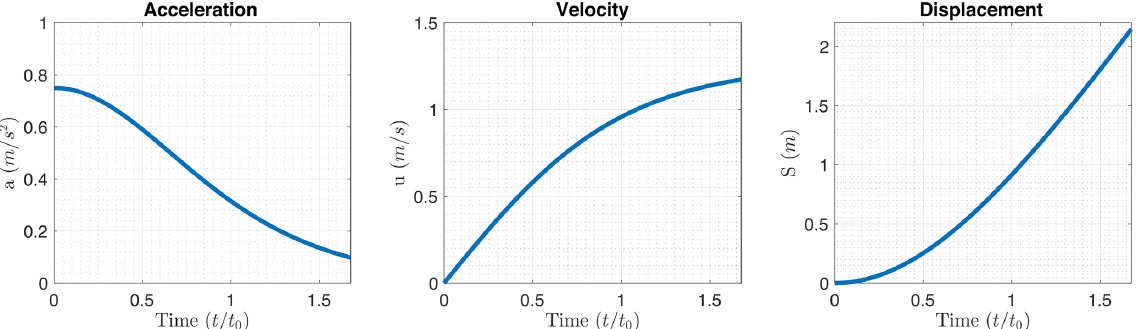
where U ( 0 ) is U at the time level t n , U ( (cid:101) k) is an